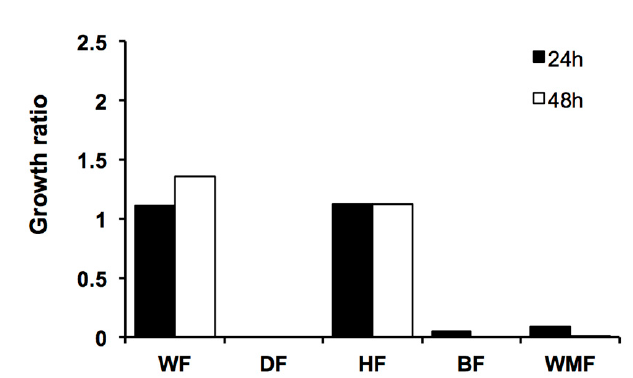
Figure 4. Susceptibility of C. glabrata to M. arbuscula fractions. Growth was monitored after 48 h of incubation at 37 °C. Growth ratios were determined in comparison to control (untreated) cells. Growth ratios below 0.5 indicate active fractions.